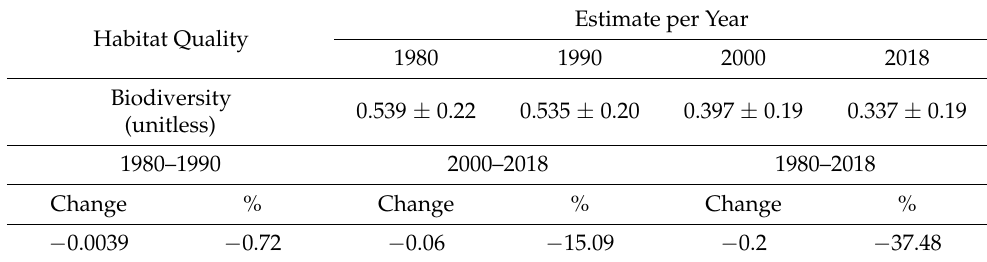
Table 7. Change in Habitat Quality value from 1980–2018.